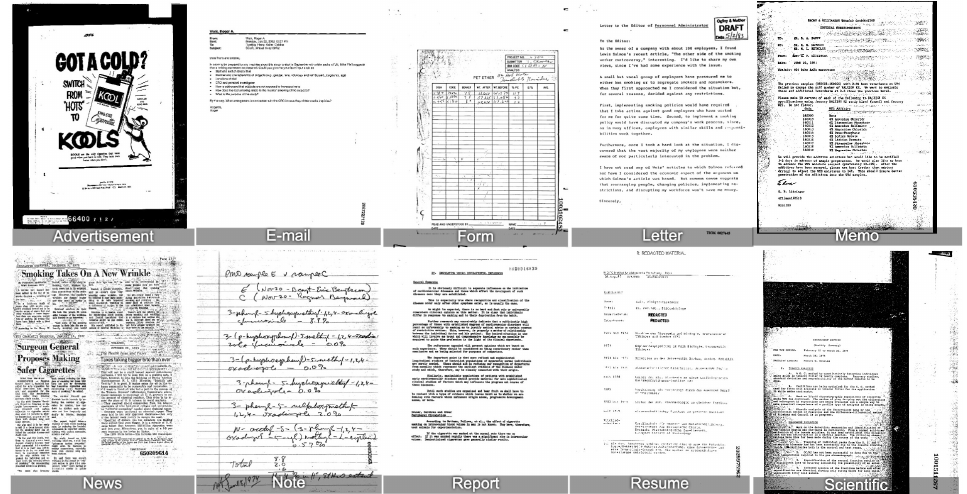
Figure 1. Sample images from each class of Tobacco-3482 dataset. We can see similarities in visual struc- tures for many classes. Furthermore, some documents have images and hence text plays insignificant roles. In some others, the text is complex or too blurred for the OCR engine to extract complete or mean- ingful text from the image. The classes in the image from left to right are: ( first row )